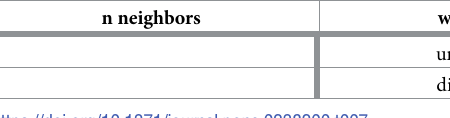
Table 7. KNN results after parameters